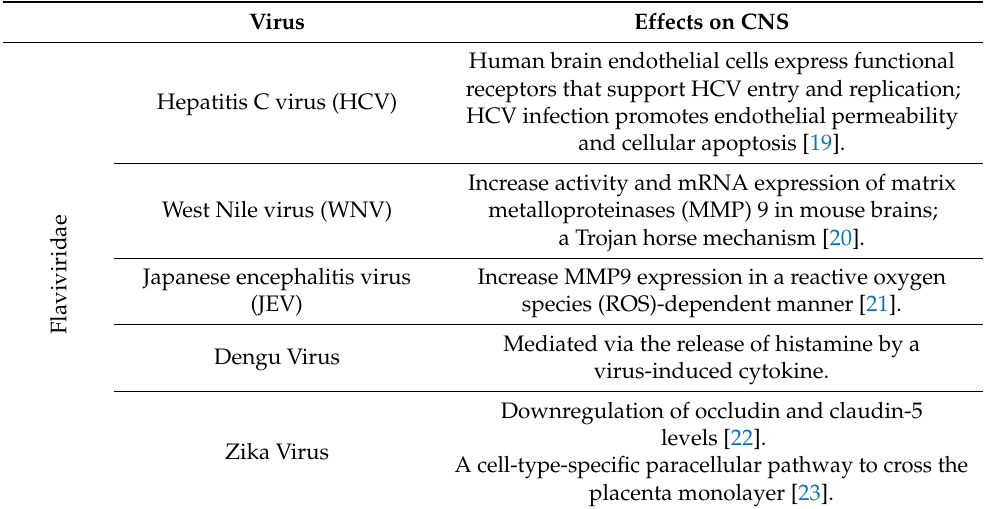
Table 1. Viral disruption of the BBB and its effects on BBB